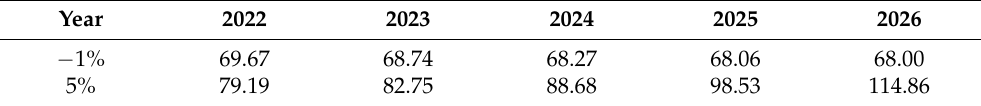
Table 20. Prediction result of water requirement with different growth rates of AVPI in Shanxi Province.